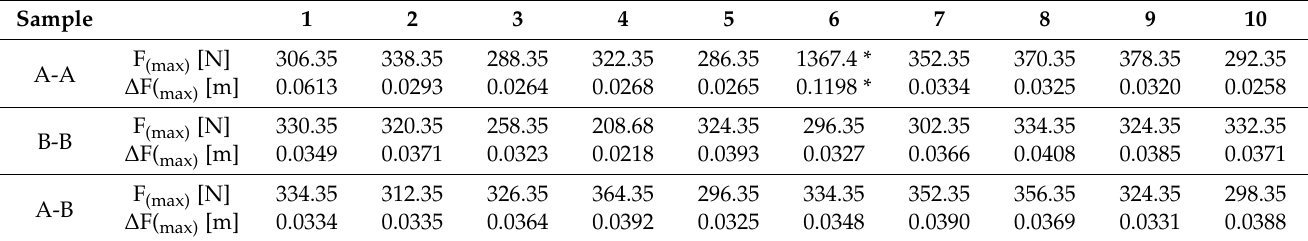
Figure 4. Fabric displacement during test in cutting direction A-A, B-B, A-B. Table 3. Power 13 fabric test